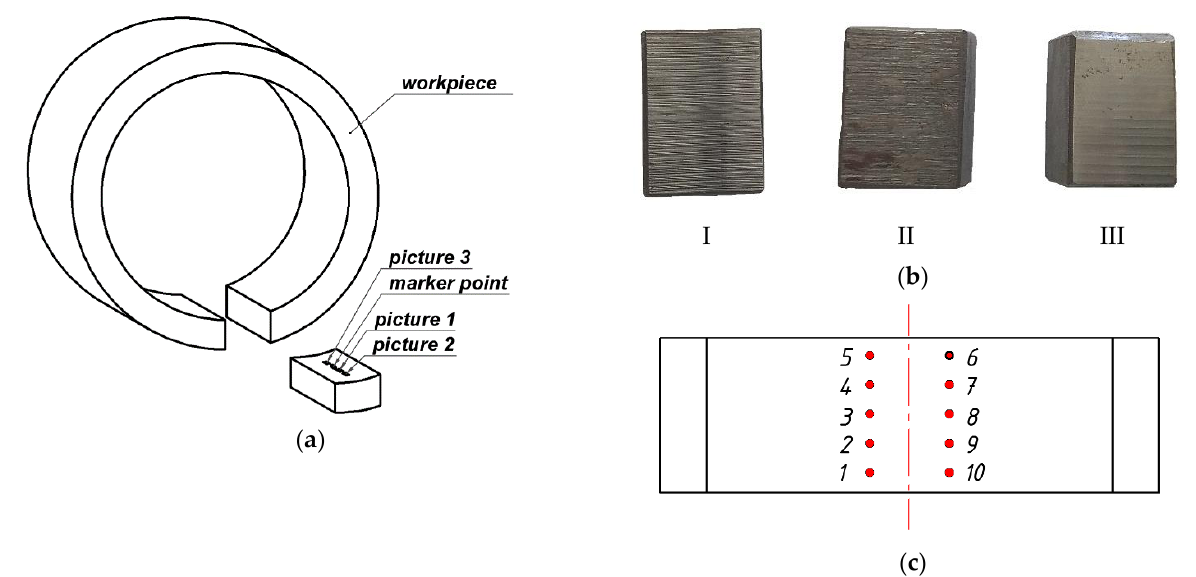
Figure 2. Template cutting scheme ( a ); photos of the template surface ( b ) after different types of machining: I—after roughing; II—after semi-finishing; III—after finish rolling; ( c ) a scheme for measuring surface hardness.